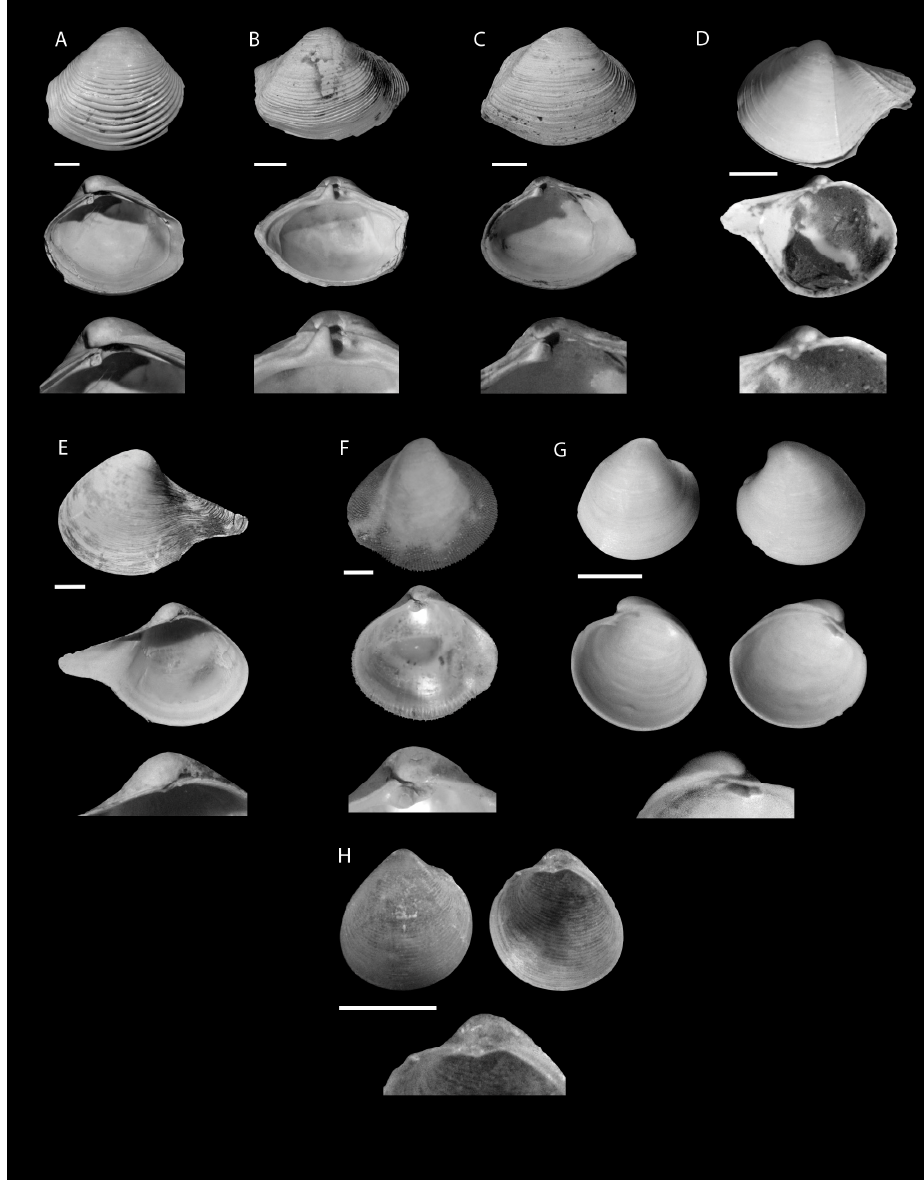
Figure 5. ( A ) Varicorbula limatula ; ( B ) Corbula sp.; ( C ) Juliacorbula aequivalvis ; ( D ) Cardiomya sp.; ( E ) Cuspidaria rostrata ; ( F ) Poromya rostrata ; ( G ) Poromyidae sp. 1.; ( H ) Poromyidae sp. 2. Scale bars = 1